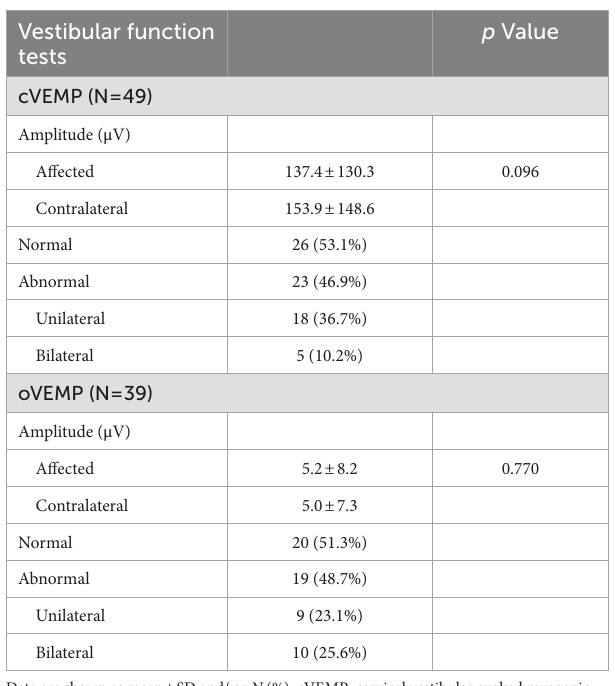
TABLE 3 Cervical vestibular evoked myogenic potentials (cVEMP) and ocular vestibular evoked myogenic protentials (oVEMP) in patients who showed CS with normal VOR